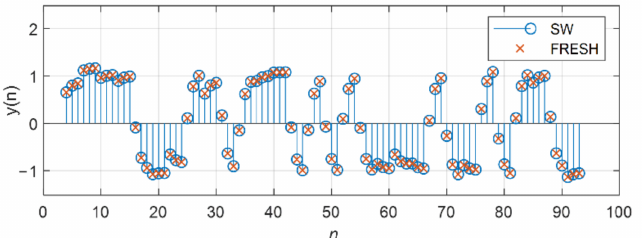
Figure 7. Output signals for sliding window filter (blue stems) and equivalent frequency shift filter (red